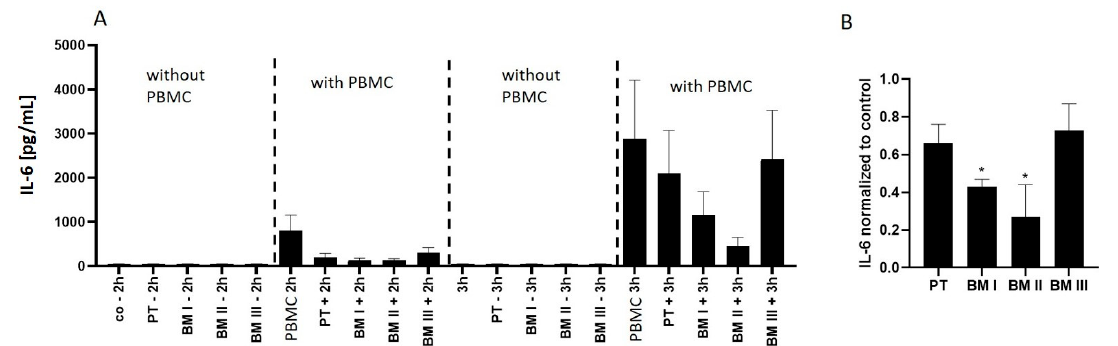
Figure 9. BM-derived cells inhibit immune cell activation. ( A ) Activation of PBMCs was analyzed by IL-6 response in the medium after co-incubation with NB cells (“with PBMC”) for 2 h or 3 h. PBMCs without NB cells were also analyzed as control (“PBMC”). In addition, tumor cells without PBMCs were assessed (“without PBMC”). ( − ): NB cells without PBMCs; (+) NB cells with PBMCs. ( B ) The IL-6 concentration after 3 h of incubation obtained from NB cells incubated with PBMCs was normalized (set to 1) to the IL-6 concentration measured in the samples containing PBMCs only. Shown are mean values ± SD of three independent experiments, including independent PMBC prep- arations, * p <